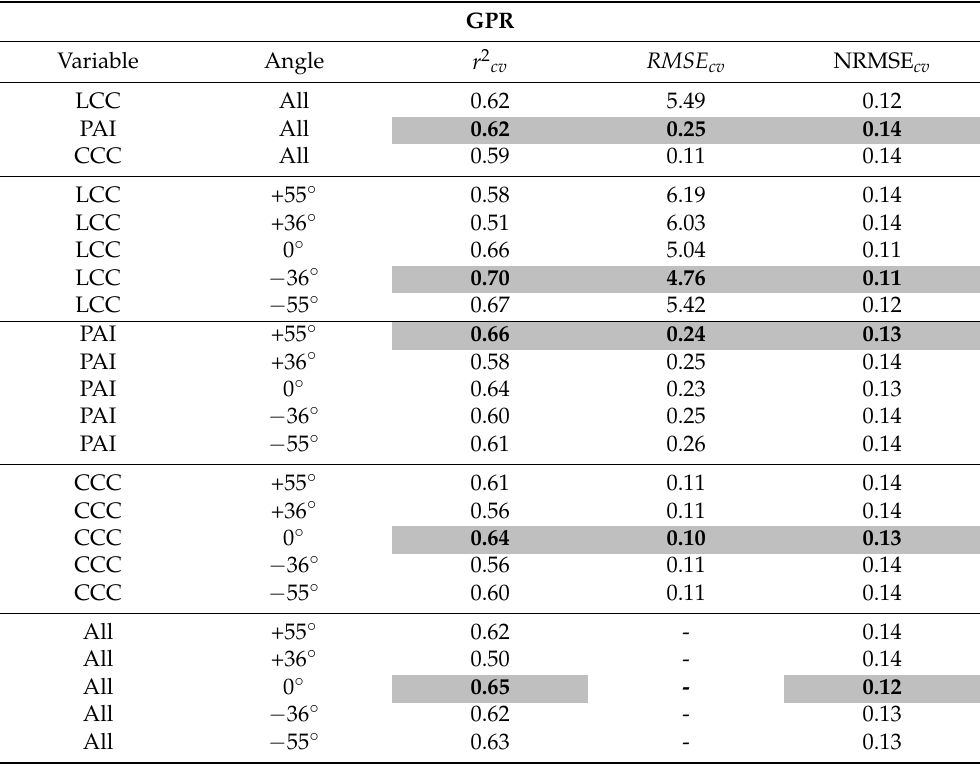
Table 3. Global Gaussian processes regression (GPR) model performance for combined field